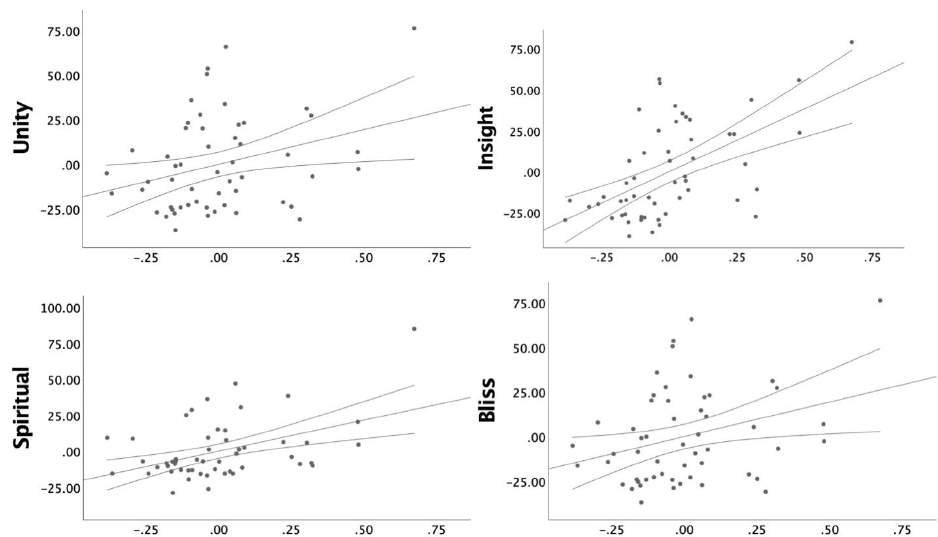
Figure 2. Partial correlation plots controlling for sex, age, and dose between responses to psilocybin (Unity, Bliss, Spiritual, and Insight) and estimates of right hemisphere rostral anterior cingulate cortex (R rACC) thickness with 95% confidence intervals. Scatter plots for non-significant results can be found in Supplementary Materials. Axes represent normalized values. Response to psilocybin is represented as the delta value; psilocybin – placebo. Table 2. Right Hemisphere Rostral Anterior Cingulate Thickness Predicts the Emotional Psilocybin Experience.